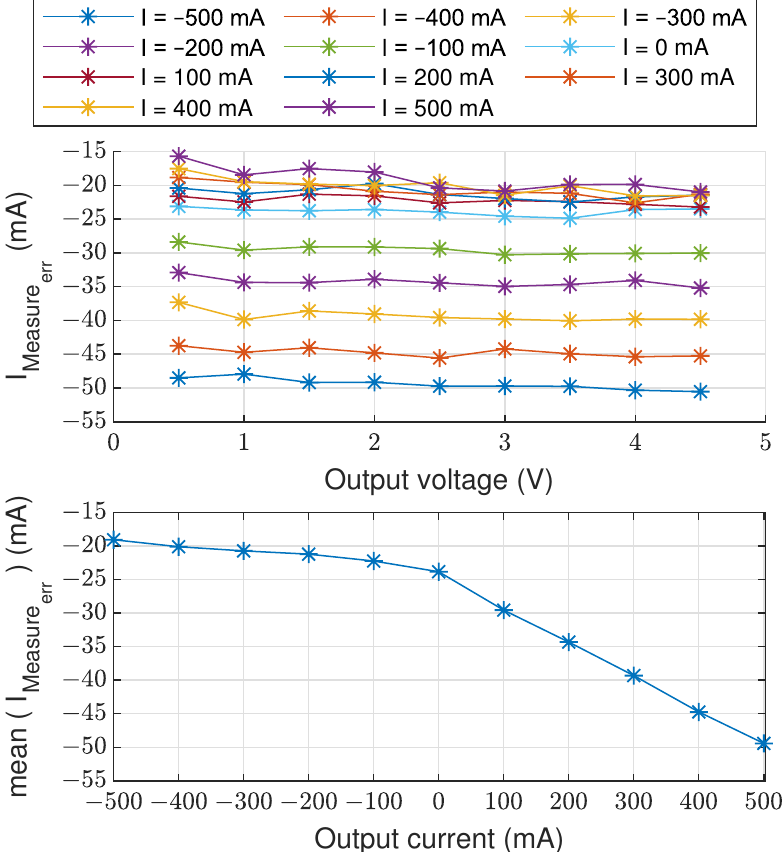
Figure 8. Characterization of the cell emulator measurement system for different current values. Measurement error for different output currents ( top ). Mean current error as a function of the output current ( bottom